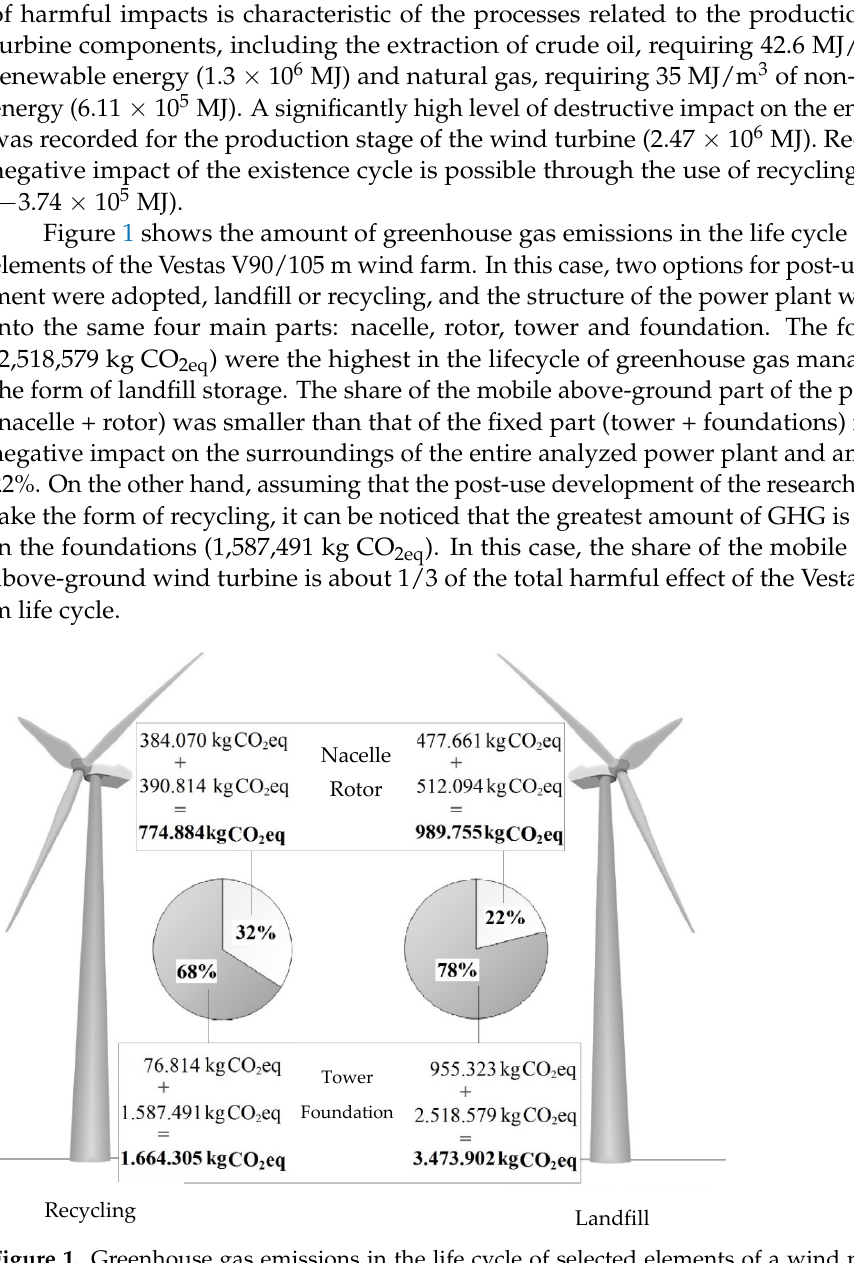
Figure 1. Greenhouse gas emissions in the life cycle of selected elements of a wind power plant [own research].